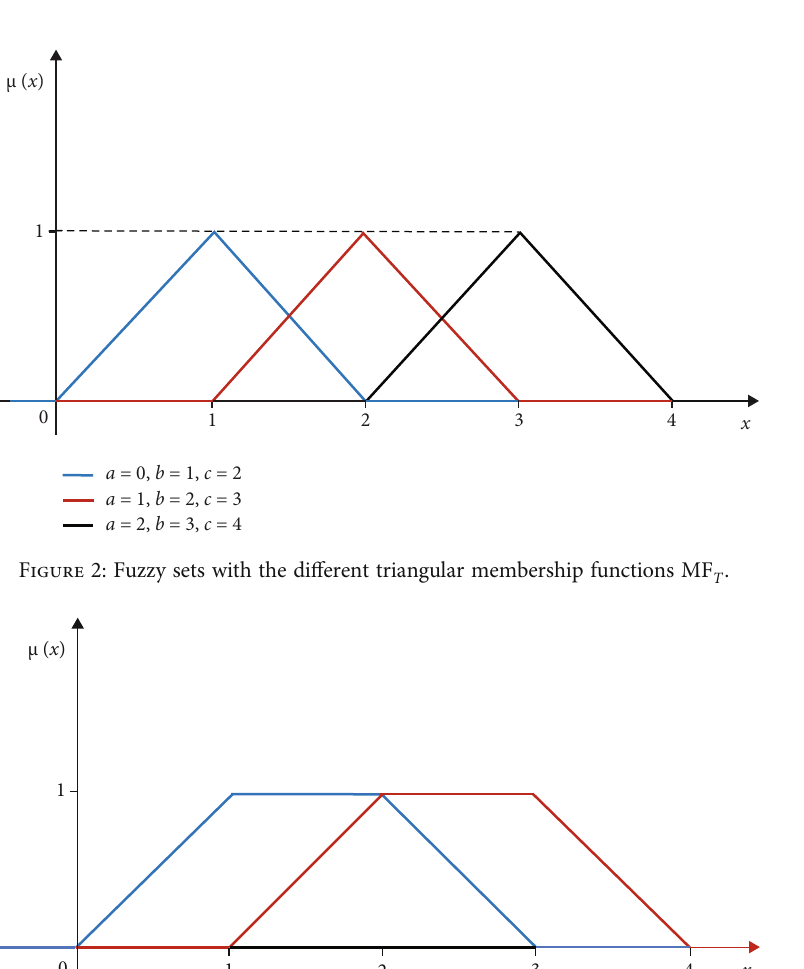
Figure 3: Fuzzy sets with di ff erent trapezoidal membership functions MF